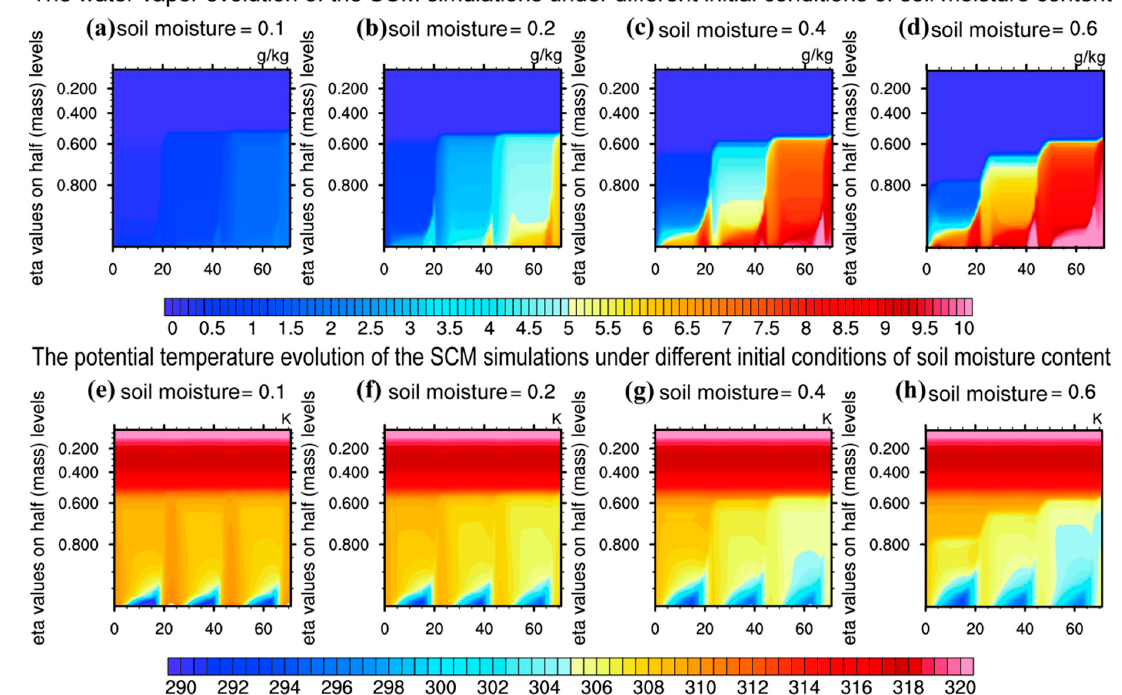
Figure 3. The water vapor evolution of the single-column model (SCM) simulations under different initial conditions of soil moisture content: ( a ) soil moisture = 0.1; ( b ) soil moisture = 0.2; ( c ) soil moisture = 0.4; and ( d ) soil moisture = 0.6. The potential temperature evolution of the SCM simulations under different initial conditions of soil moisture content: ( e ) soil moisture = 0.1; ( f ) soil moisture = 0.2; ( g ) soil moisture = 0.4; and ( h ) soil moisture = 0.6. All simulations are at Urumqi (43.79° N, 87.65° E). The x -axis represents the hours since the simulation, while the y -axis shows the model vertical coordinate (the small value represents high altitude).